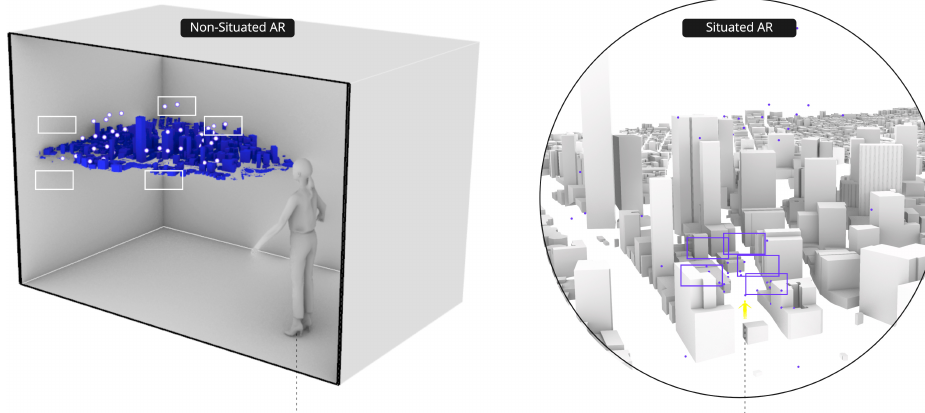
Figure 5. Immersive Analytics compared to Situated Analytics . The real world is schematically represented in grey. AR content is shown in blue. On the left side, a user is displaying a Smart City environment (blue model) in non-situated AR. Interactables are highlighted in white, and several pop-ups showing information (white squares) are opened. Immersive Analytics make use of 3D space to visualise content but can be independent of the spatial context surrounding them. On the right side, a user (in yellow) is walking through the Physical Environment of the Smart City. In Situated Analytics, interactables are AR content that is displayed in situ for the Physical Environment that they describe. Similarly to (a), pop-ups (blue squares) are showing content to the user in AR space. Generated with https://miro.com and https://rhino3d.com with royalty-free models from